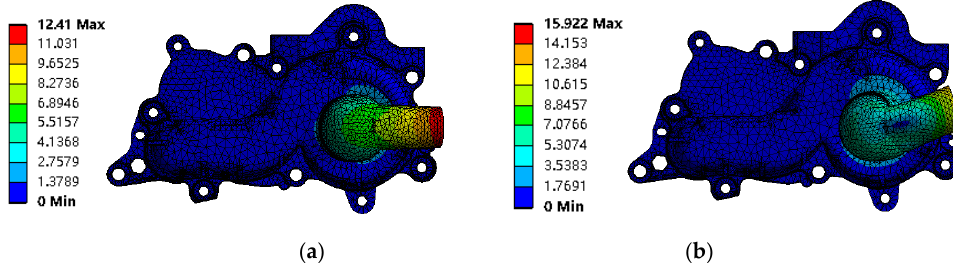
Figure 17. Mode shapes of pumps structure with amplitude unit mm: ( a ) 1 st mode; ( b ) 4 th mode.